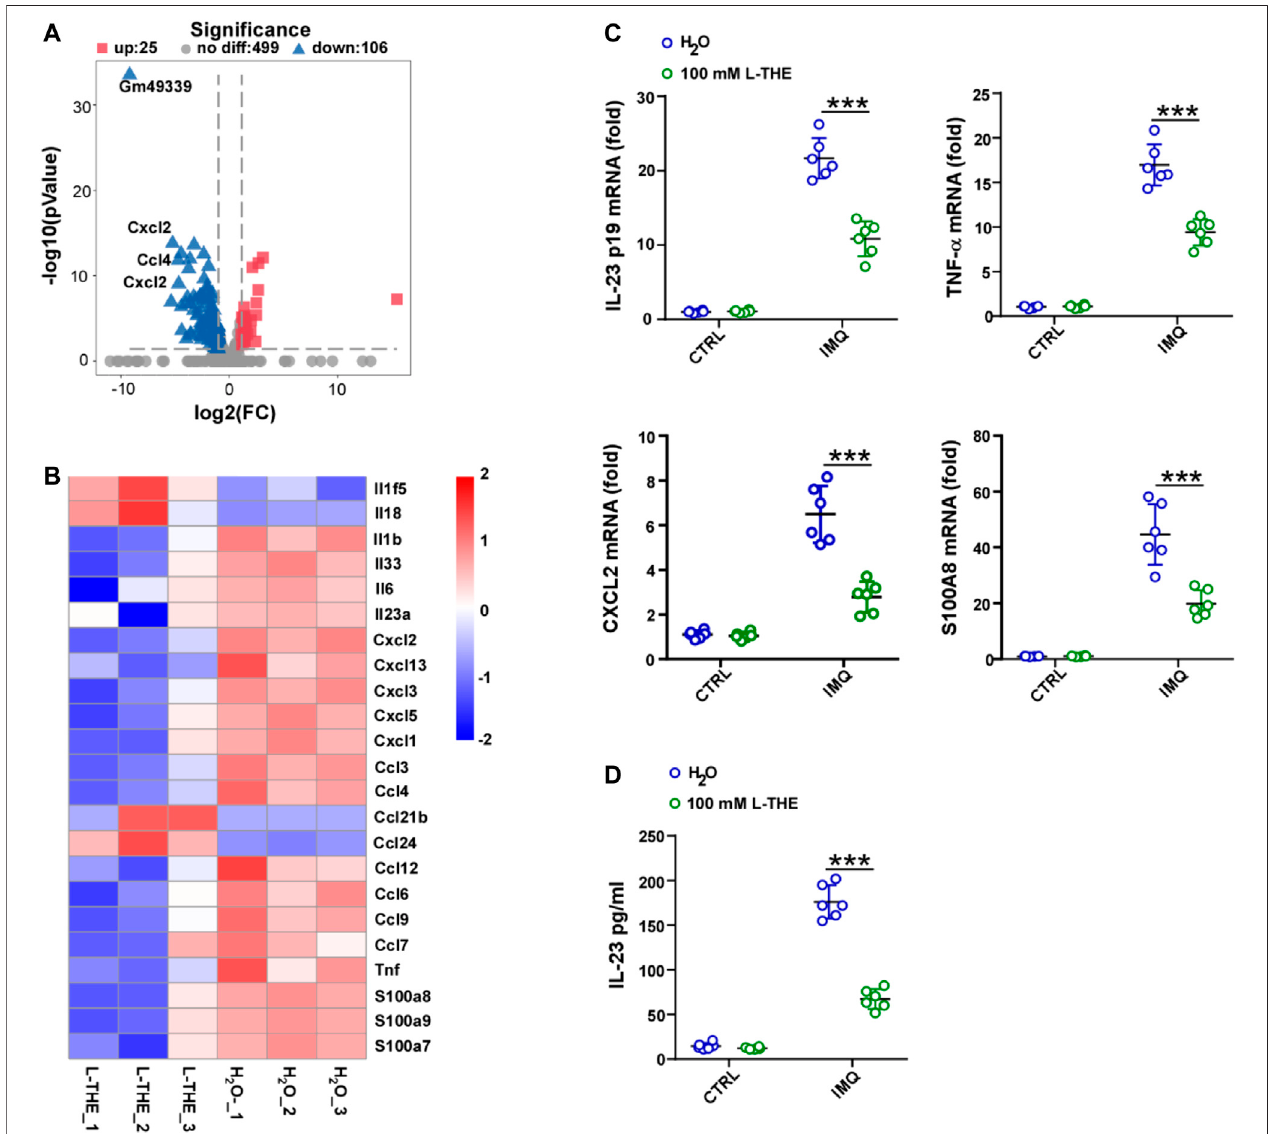
FIGURE 3 | L-THE downregulates the expression of in fl ammatory genes. (A,B) Volcano plot. (A) showed the expression of in fl ammatory response associated genes, and heatmap. (B) showed the signi fi cantly differentiated genes about interleukin, CXCL, and CCL family genes based on RNA-seq data from IMQ-induced psoriasis mice treated with 100 mM L-THE or H 2 O for 5 days. (C) RT-PCR analysis of the mRNA levels of IL-23p19, TNF- α , CXCL2, and S100A8 in IMQ-induced psoriasis mice ( n (cid:1) 6 per group) treated with 100 mM L-THE or H 2 O for 0 or 5 days. (D) ELISA analysis of IL-23A in IMQ-induced psoriasis mice ( n (cid:1) 6 per group) treatedwith100 mM L-THEorH2Ofor0or5 days.Dataisrepresentativeofthreeindependentexperiments. p valuesaredeterminedbytwo-wayANOVA.*** p <